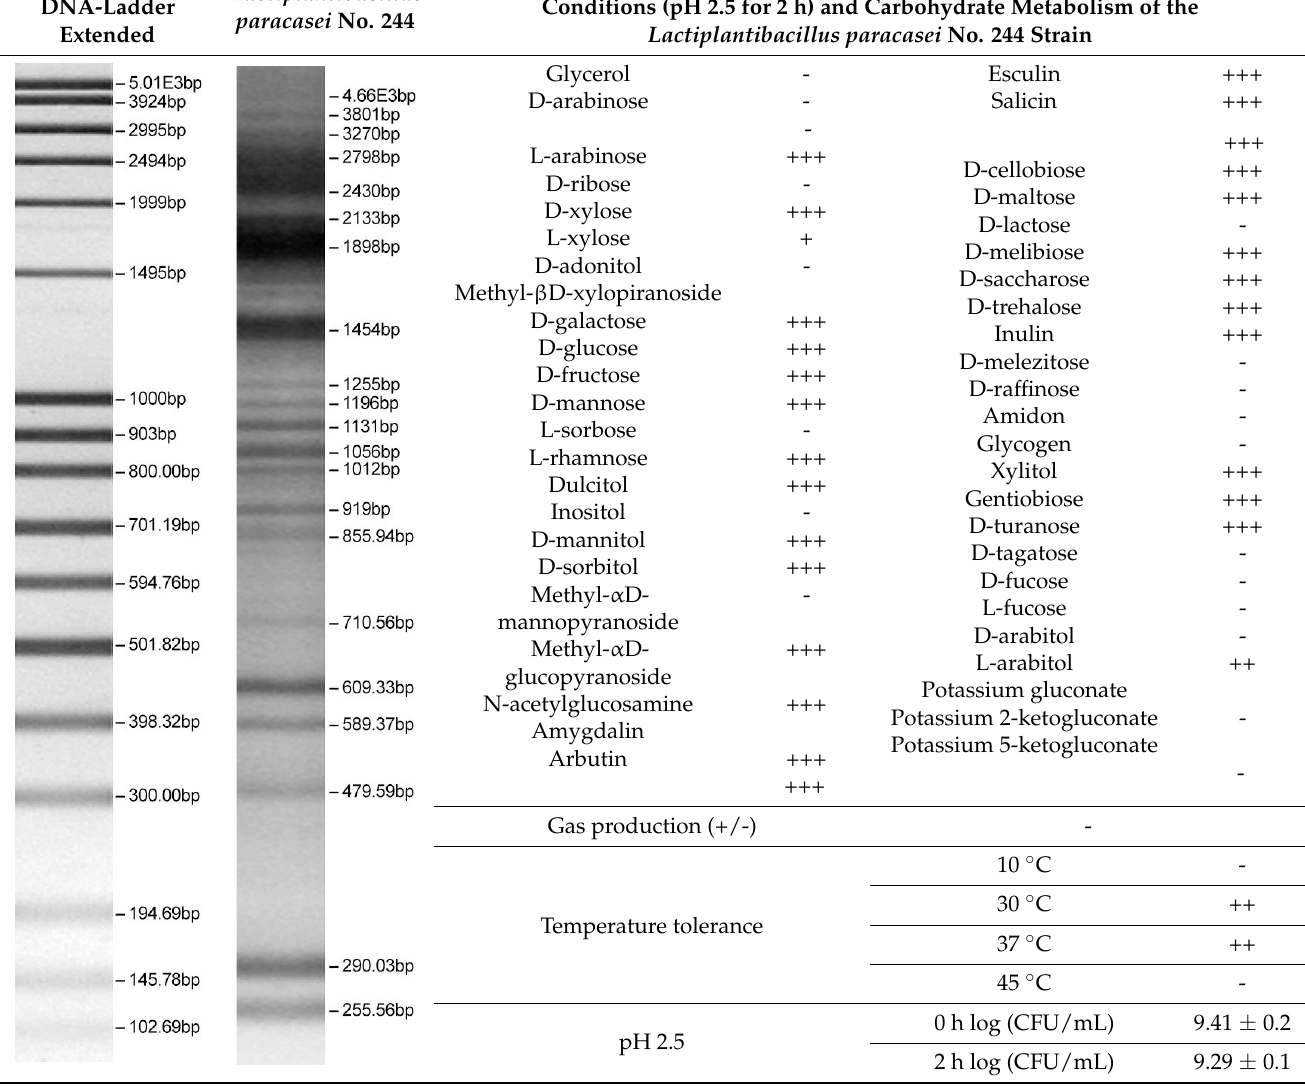
Table 1. Characteristics of the Lactiplantibacillus paracasei No. 244 strain. 100 bp DNA-Ladder